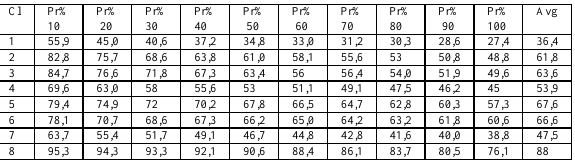
Table 2 and Table 3 illustrate the overall recognition rate obtained for different precision values using the similarity measure of Chi-square for each category.